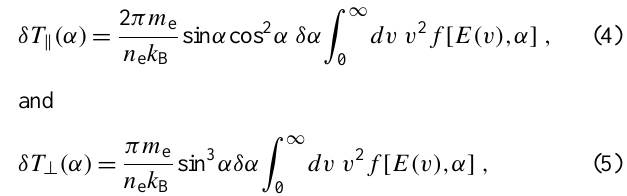
Fig. 6. Electron distributions for α > 90 ◦ ( v k < 0). Additionally, panel (c) also shown distributions for α < 90 ◦ . The overlap be- tween distributions seen by Custer 2 and THEMIS b is related to the similar bowshock crossing points for electrons arriving at each spacecraft. This is particularly true for low energy electrons. The circles in panel (c) correspond to the energies shown in Fig. 4.